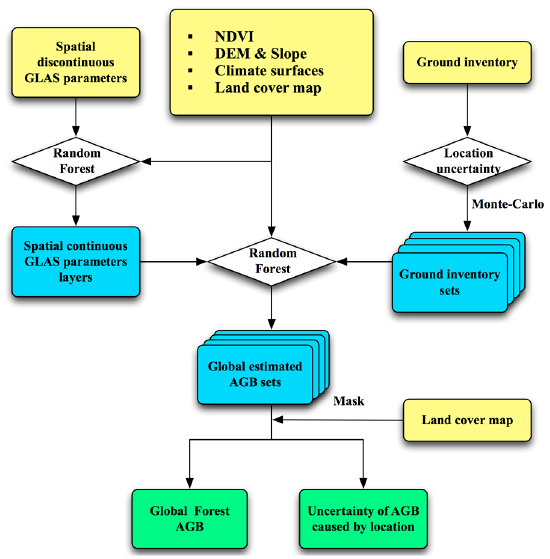
Figure 1. The workflow for estimating global forest aboveground biomass (AGB) distribution from multisource remotely sensed data and ground inventory data.